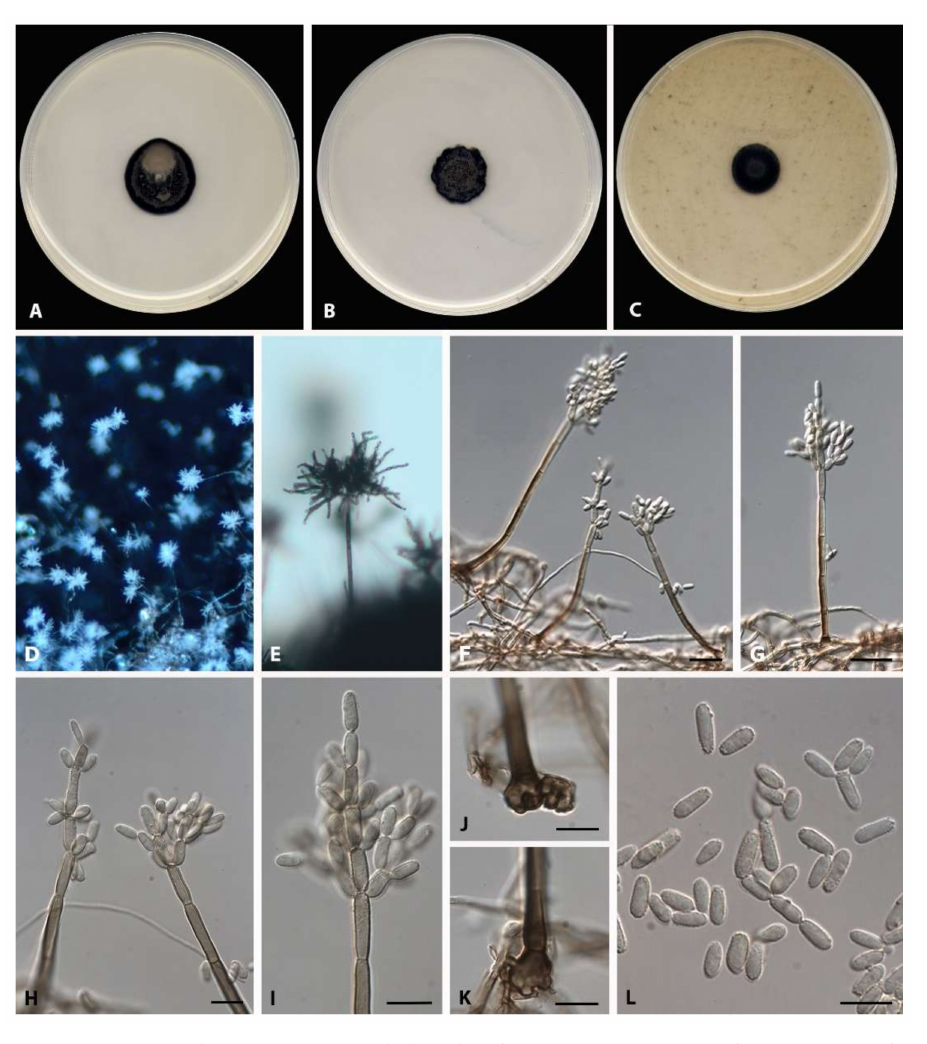
Figure 3. P. vietnamensis (ex-type FMR 17593). ( A – C ) Colonies on PDA, PCA, and OA, respectively, after 30 days at 25 ◦ C. ( D – I , L ) Conidiophores and conidia. ( D , E ) Conidiophores under stereomicroscope. ( J , K ) Detail of conidiophore basal cells. Scale bars: ( F , G ) = 20 µ m; ( H–L ) = 10 µ